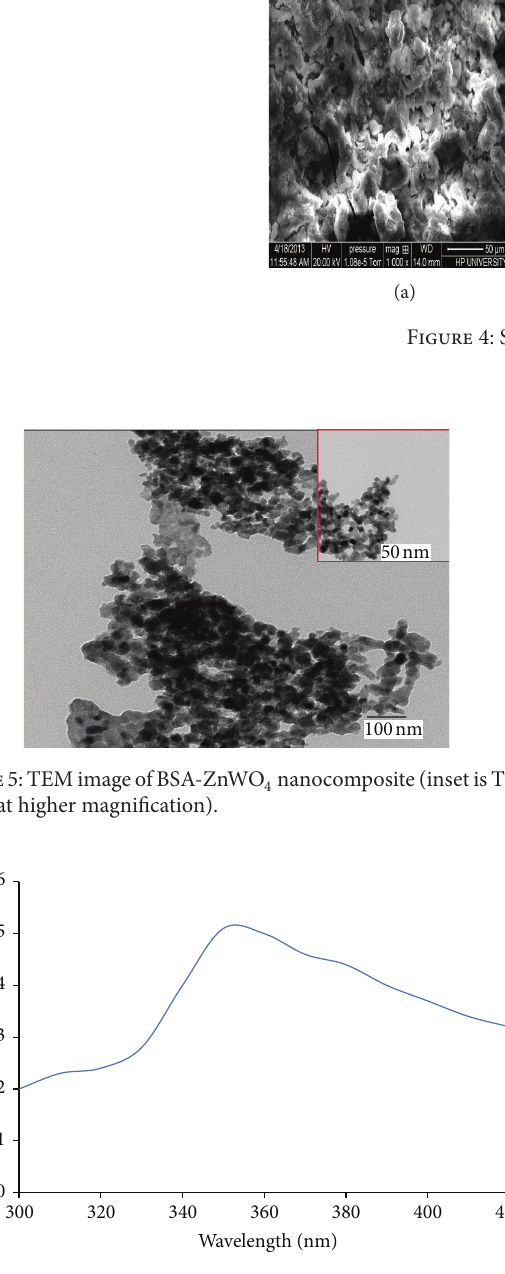
Figure 6: UV-Vis spectrum of BSA-ZnWO 4 nanocomposite.